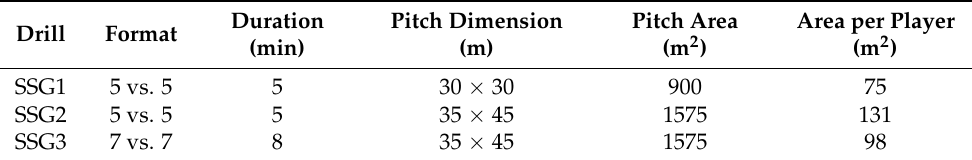
Table 1. Small-sided game (SSG) features evaluated in this